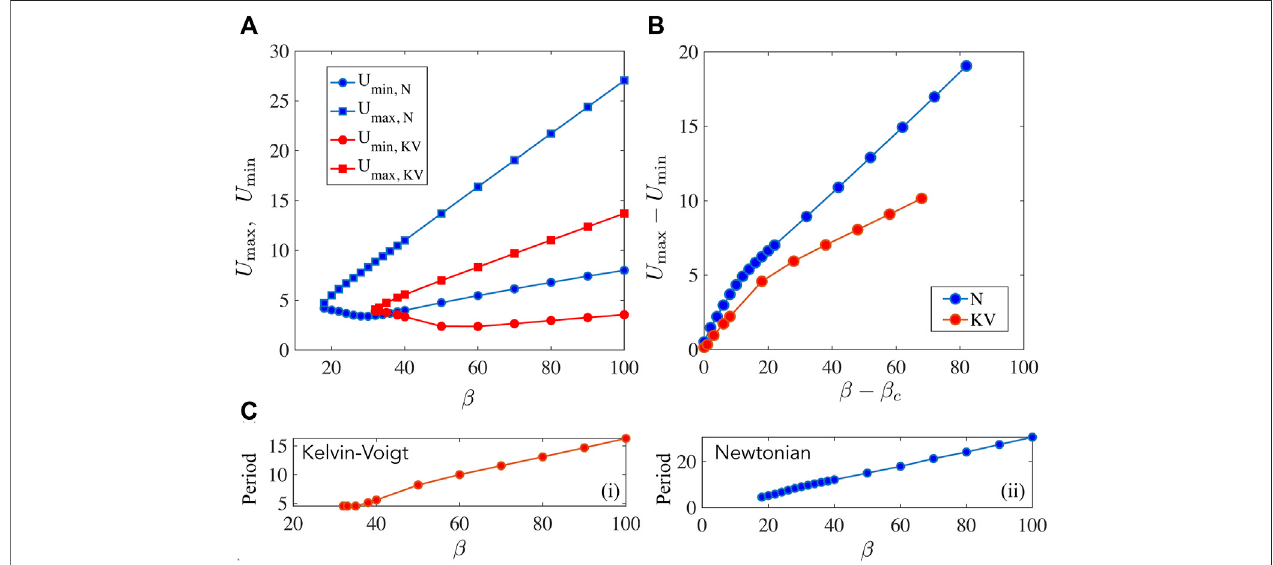
FIGURE 7 | Non-linear solutions for Newtonian and Kelvin-Voigt media compared with the focus on the fi lament displacements U and period of oscillations. (A) Here we plot U max and U min , the maximum and minimum values attached by U ( t ) over a cycle when the oscillations have stabilized, as a function of β . Parameters are E (cid:2) 2 and Ψ =0.8. The Newtonian case (N) corresponds to B (cid:2) 0 . 1 while the Kelvin-Voigt (KV) case corresponds to B (cid:2) 0 . 1 and B (cid:2) 1. (B) Amplitude of the fi lament s 2 2 1 oscillations |U max − U min | here plotted as a function of the deviation from the critical point β − β c . Here the critical values β c are different for the N and KV cases and maybereadofffrom (A) .In (C) ,weplotthe(dimensionless)oscillationperiod.NotethattheperiodfortheKVcaseshownin(i)istypicallylowerthanthatfortheNewtonian case (ii) indicating higher frequencies.